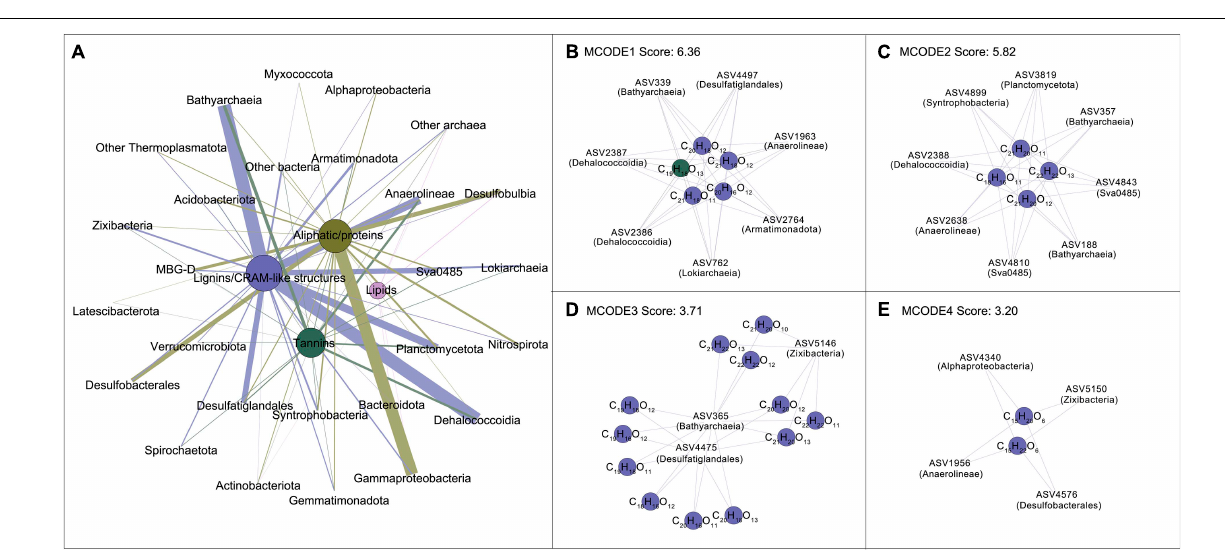
(Dombrowski et al., 2018). Most CAZymes identified in archaeal genomes were AA4, AA6, AA7, CBM44, GH109, and GH57 families, while AA3, CBM48, GH3, GH23, and GH77 were